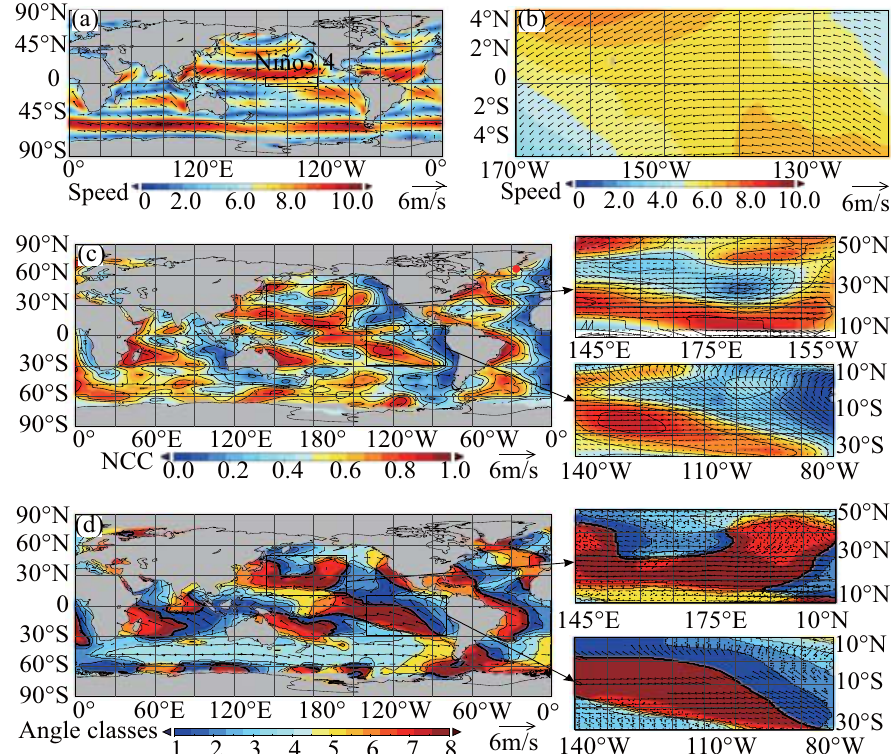
Fig. 3. The modified correlation product of September 2002. (a) is the original data, (b) is the template, and the NCC coefficient result and direction classification result can be seen in (c) and (d)